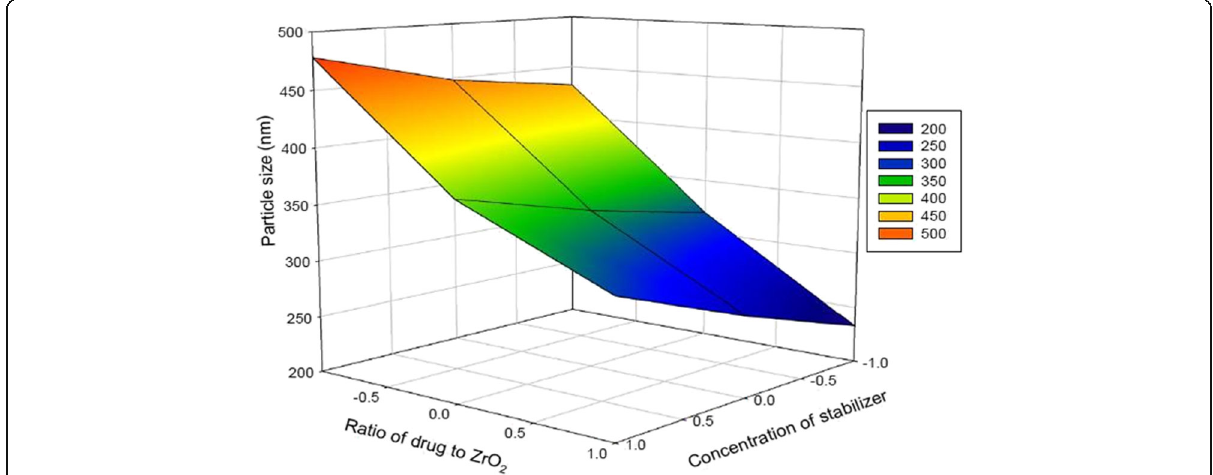
Fig. 5 3D mesh plot of showing the effect of concentration of stabilizer and the ratio of drug to ZrO 2 on particle